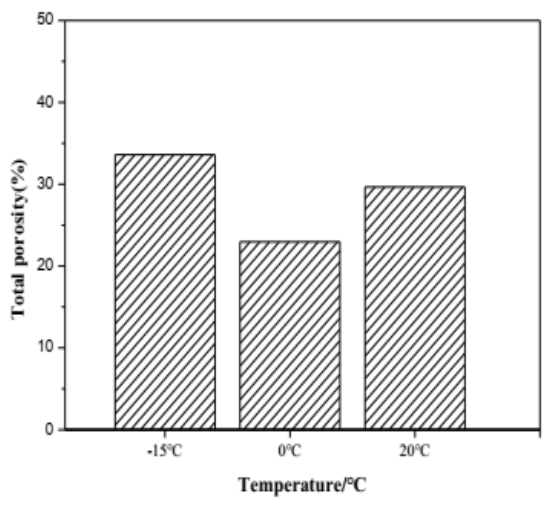
Figure 9. Porosity characteristics of samples hydrated for 28 days at different temperatures.